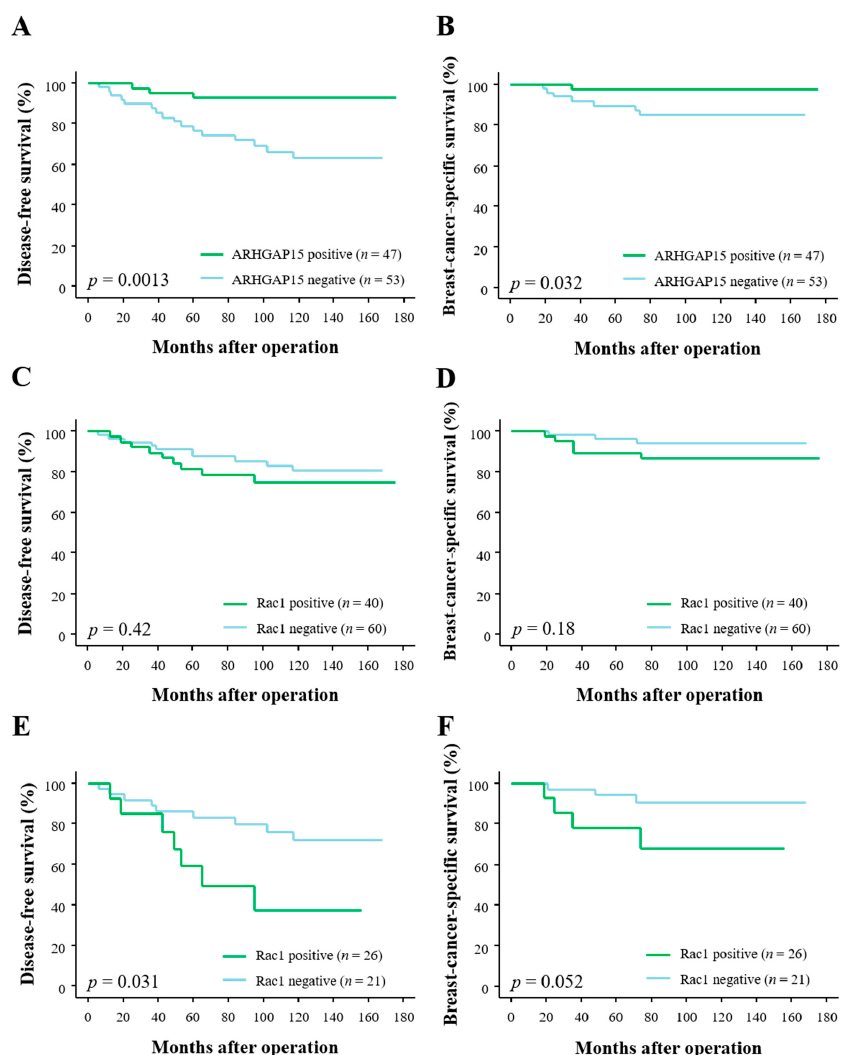
Figure 2. Disease-free survival and breast-cancer-specific survival of 100 breast carcinoma patients according to ARHGAP15 and Rac1 immunoreactivity. ( A , B ) Disease-free survival ( A ) and breast-cancer-specific survival ( B ) according to ARHGAP15 immunoreactivity. ( C , D ) Disease-free survival ( C ) and breast-cancer-specific survival ( D ) according to Rac1. ( E , F ) Disease-free survival ( E ) and breast-cancer-specific survival ( F ) according to Rac1 in ARHGAP15-negative cases ( n = 47).